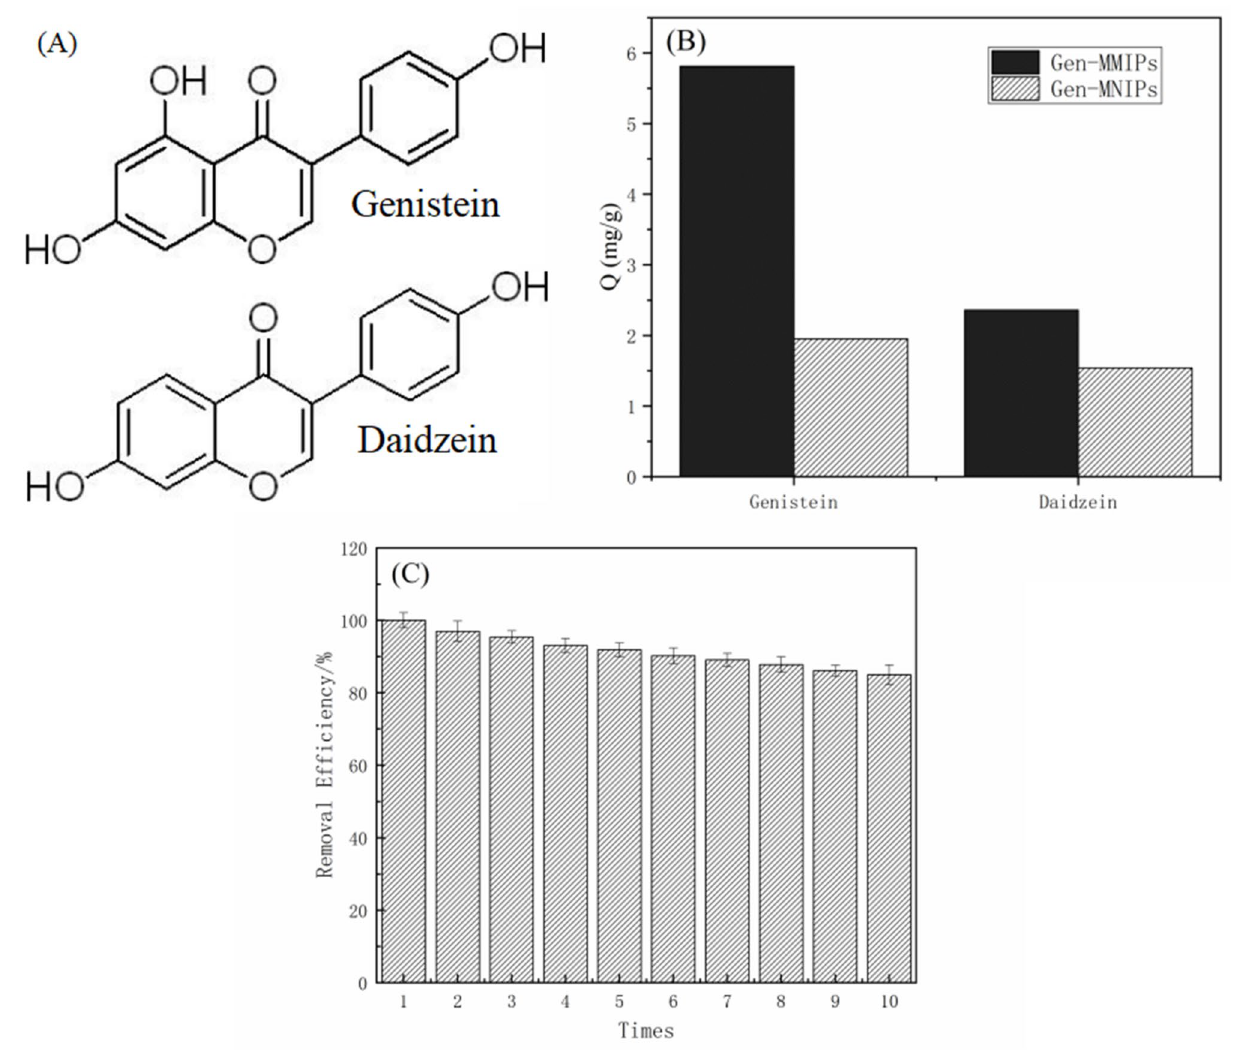
Figure 5. ( A ) The structures of genistein and daidzein, ( B ) selective adsorption of Gen-MMIPs and Gen- MNIPs for genistein and daidzein. ( C ) Adsorption of Genistein by Gen-MMIPs in ten adsorption–desorption